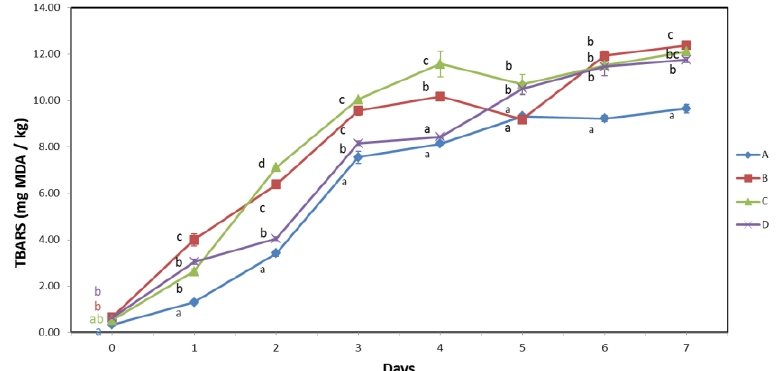
Figure 5. TBARS of samples A and B handled by the traditional method, and samples C and D handled by the modified handling method during 7 days of storage at 0 °C. Capital letters A, B, C and D (legend) indicate different sample batches. Lowercase letters (a, b, c, d) on the same day indicate significant differences among different sample batches ( p ≤ 0.05).